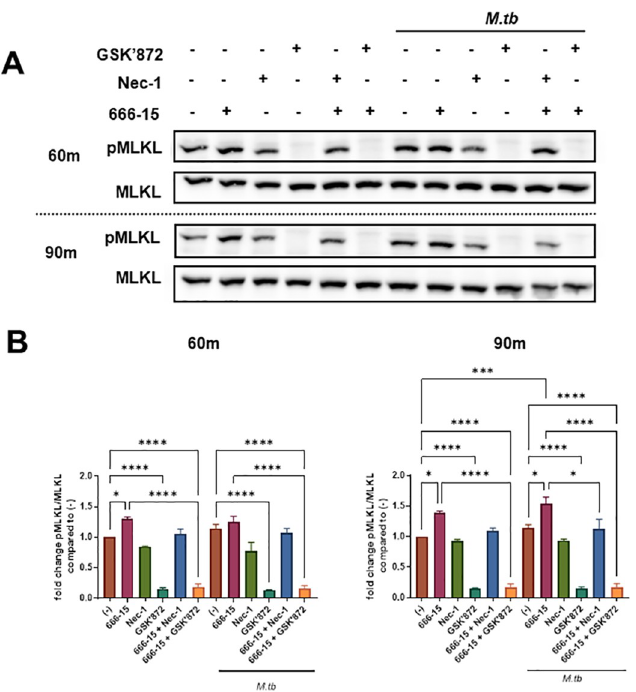
Fig 7. pMLKL induced by CREB inhibition in human macrophages infected with M . tb is dependent on RIPK1/ RIPK3. A) MDMs were pretreated with for 60 min with DMSO or CREB inhibitor 666–15 +/- Nec-1 or GSK’872 then infected or not with M . tb H 37 R v MOI 10. Cell lysates were collected and probed by WB for phosphorylated and total MLKL at the indicated time points. A representative experiment is shown of n = 5, 4 donors. B) Densitometry was determined and graphed as fold change ± SEM of phosphorylated protein to total protein. n = 5, 4 donors. One-way ANOVA with Tukey’s post-test; * p < 0.05, ** p < 0.01, *** p < 0.001, **** p < 0.0001.